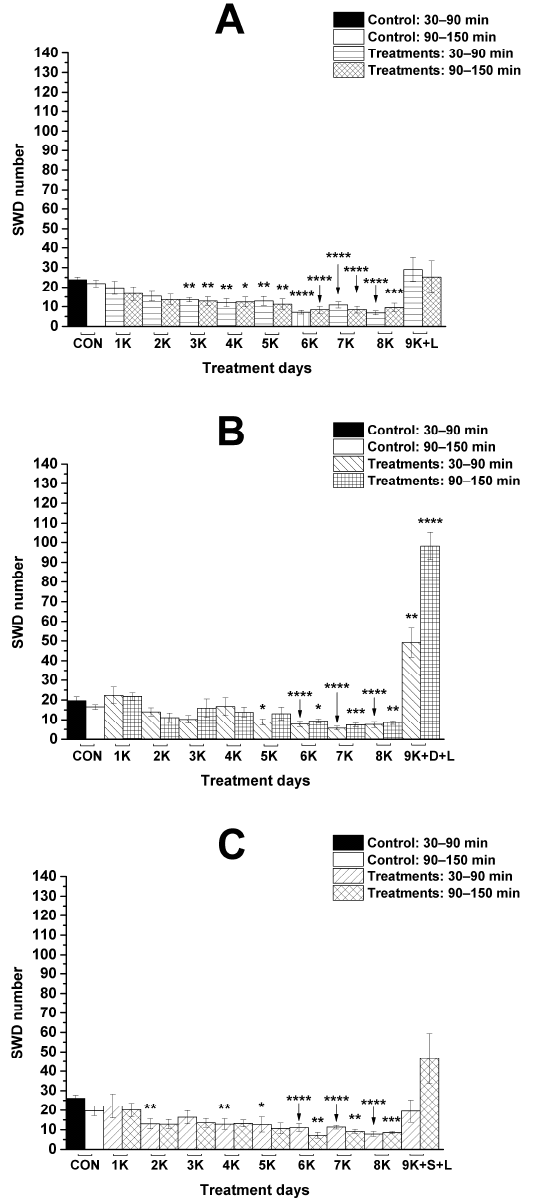
Figure 3. Influence of combined administration of KEKS-supplemented food (paste-like standard rodent chow containing 10% ketone ester/KE, 10% ketone salt/KS and 1% saccharin) with LPS (50 μ g/kg) ( A ), with DPCPX (0.2 mg/kg) and LPS ( B ) and with SCH58261 (0.5 mg/kg) and LPS ( C ) on SWD number (groups 4, 5, and 6, respectively). Abbreviations: 1K, first day of KEKS food administration, 2K, second day of KEKS food administration and so on; 9K + D + L, 9th day of KEKS food administration and co-administration of i.p. DPCPX (0.2 mg/kg) and LPS (50 µ g/kg); 9K + L, 9th day of KEKS food administration and co-administration of i.p. LPS (50 µ g/kg); 9K + S + L, 9th day of KEKS food administration and co-administration of i.p. SCH58261 (0.5 mg/kg) and LPS (50 µ g/kg); CON, control; SWD, spike-wave discharge. *: p < 0.05, **: p < 0.01, ***: p < 0.001 and ****: p <